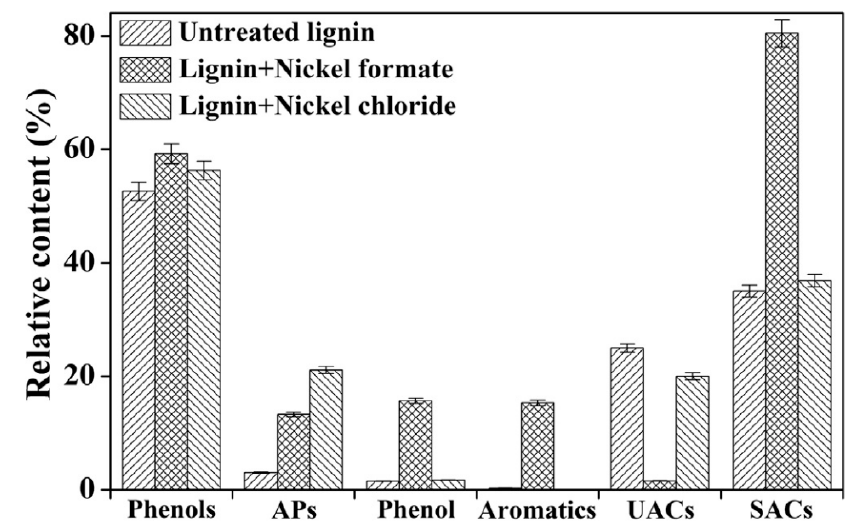
Figure 2. Effects of nickel salts on the characteristics of typical products paralyzed from alkali lignin at 600 ◦ C. APs: Alkylphenols; UACs: Unsaturated aromatic compounds; SACs: Saturated aromatic compounds [11] .